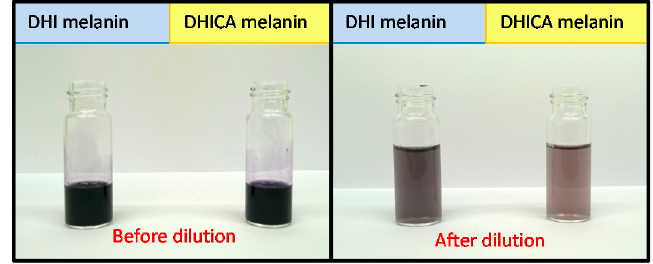
Figure 4. Melanins from DHI (blue box) and DHICA (yellow box) oxidation before and after 1:90 dilution in 1% PVA-containing buffer.